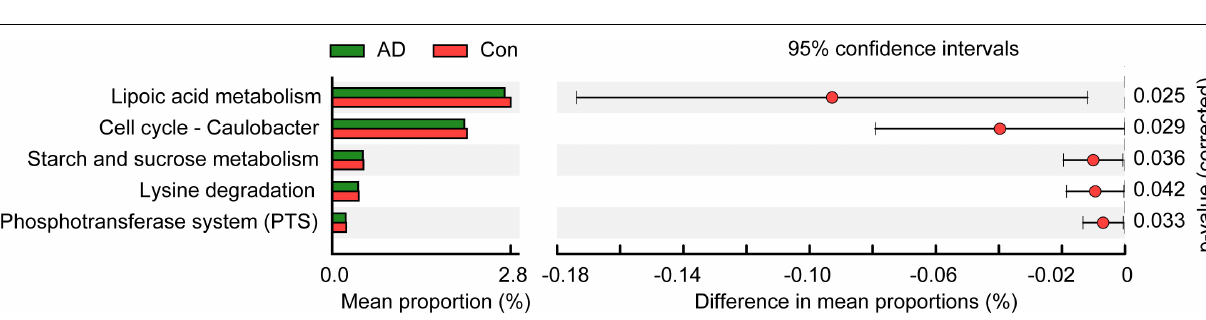
FIGURE 4 | PiCRUSt-based examination of the fungal microbiome of the stable AD patients and the healthy controls. The different fungal functions were evaluated between them based on two-sided Welch’s t -test. Comparisons between the groups for each KEGG functional category (level 3) are shown by percentage. The Benjamini–Hochberg method was used for multiple testing correction based on the false discovery rate (FDR) through